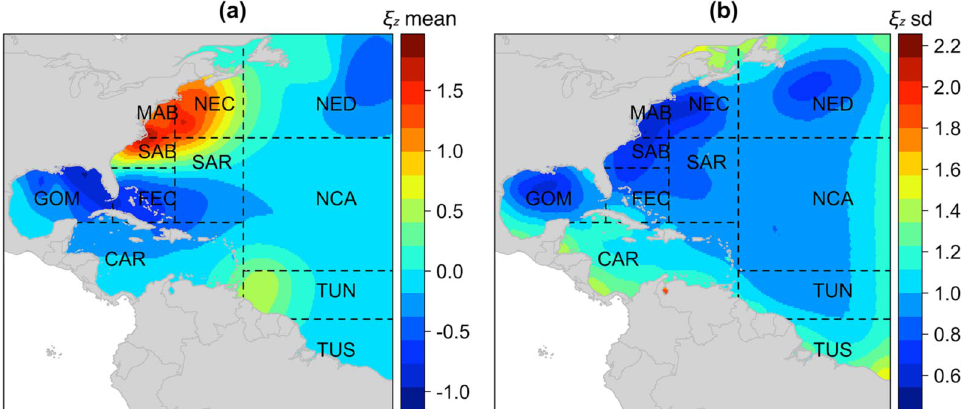
Figure 4. ( a ) Posterior mean and ( b ) standard deviation of the spatial random field on logit( p ) from model M7 fitted to data from 11 fishing zones. Abbreviations represent the following: NED – Northeast district, NCA – North Central Atlantic, TUN – Tuna North, TUS – Tuna South, NEC – Northeast coast, SAR – Sargasso region, CAR – Caribbean region, MAB – Mid-Atlantic bight, SAB – South Atlantic bight, FEC – Florida east coast, GOM – Gulf of Mexico. Plot is made using R package lattice (version 0.20–38, http:// lmdvr.r- forge.r- proje ct. org) in statistical program R (version 3.6.3, http:// www.R- proje ct. org/). Map data is from R package maps (version 3.3.0, https:// CRAN.R- proje ct. org/ packa ge=